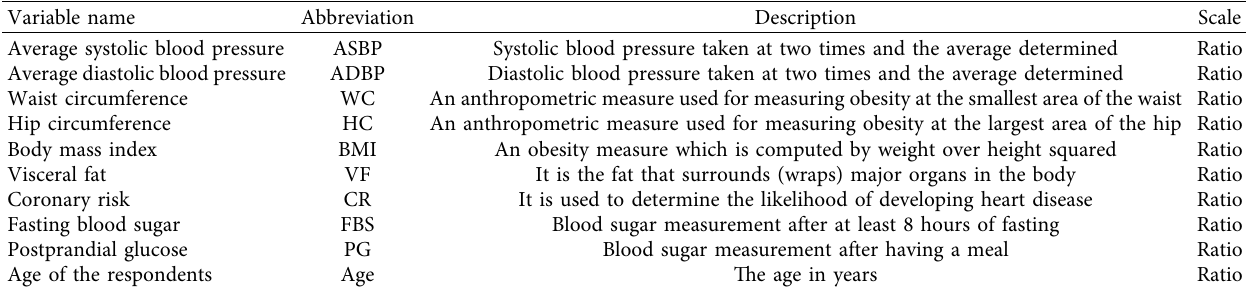
Table 1: The variables in the